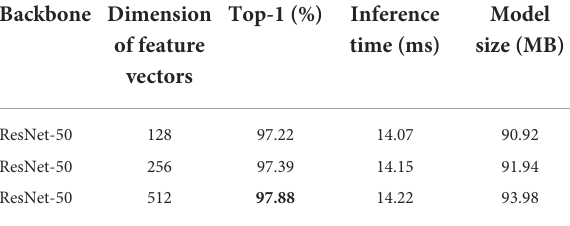
TABLE 2 Performance for feature extraction networks with different dimensions of feature vectors. Backbone